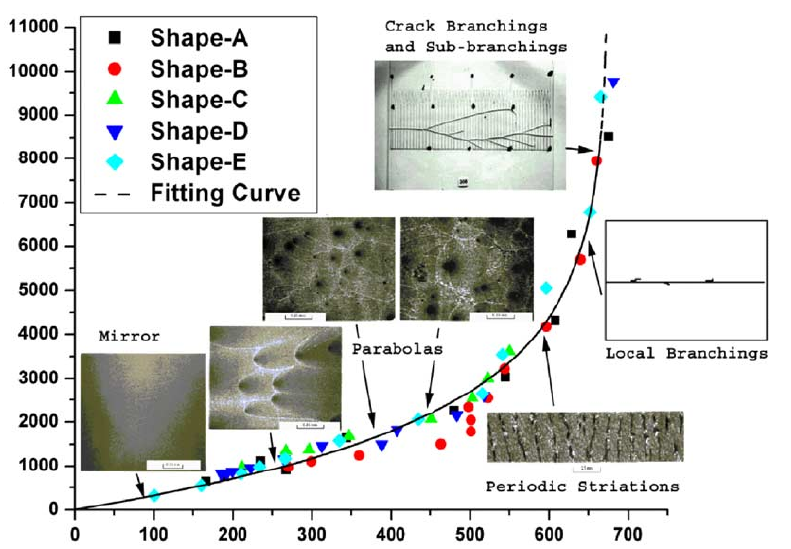
Figure 6. Fracture energy G c and the fracture characteristics corresponding to different crack speed regions for a Polymethyl Methacrylate (PMMA) plate [51].